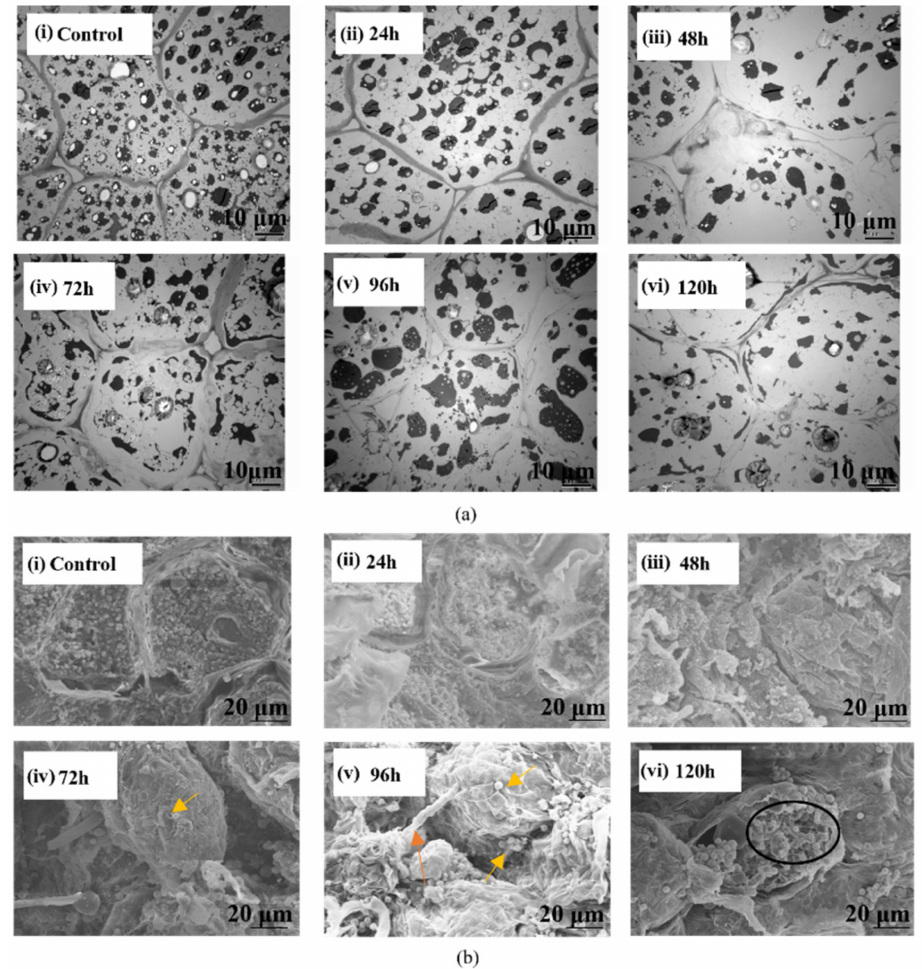
Figure 8. TEM and SEM images of peanut kernel sections inoculated with A. flavus (TEM images ( a ) × 1500, SEM images ( b ) ×